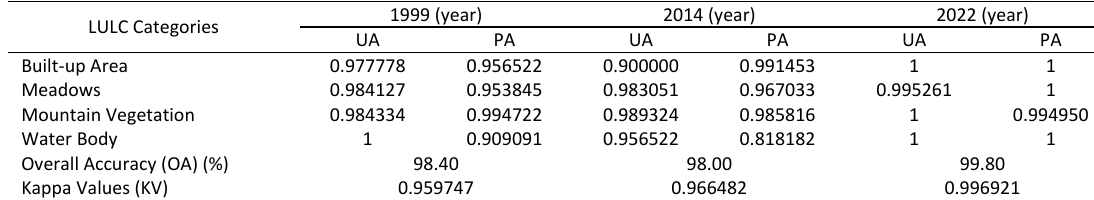
Table 4: Accuracy Assessment of the classified Landsat images